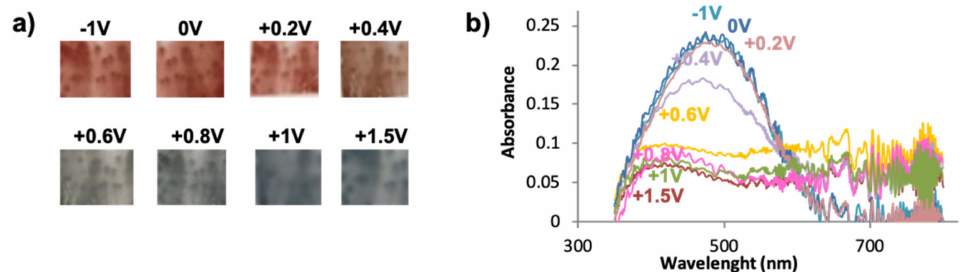
Figure 4. ( a ) Multichromic behavior of bisP/C 60 at different potentials, ( b ) UV-VIS spectroelectro- chemistry for bisP/C 60